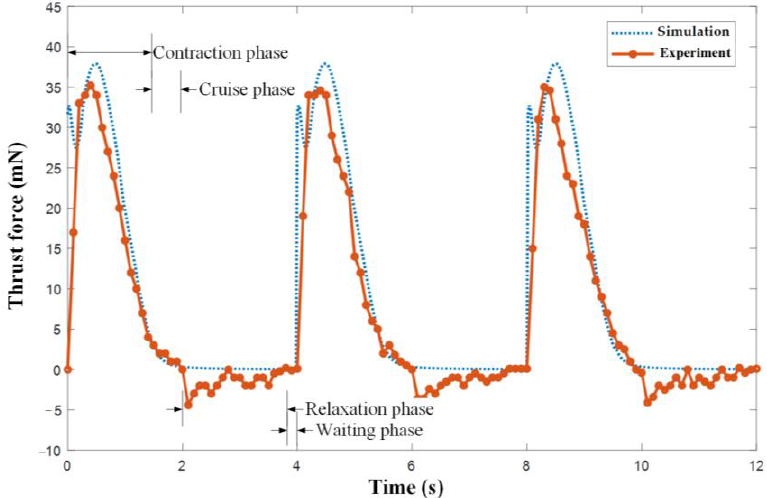
Figure 19. Simulated and experimental thrust forces of the origami flexiball inspired bionic jellyfish robot. fish